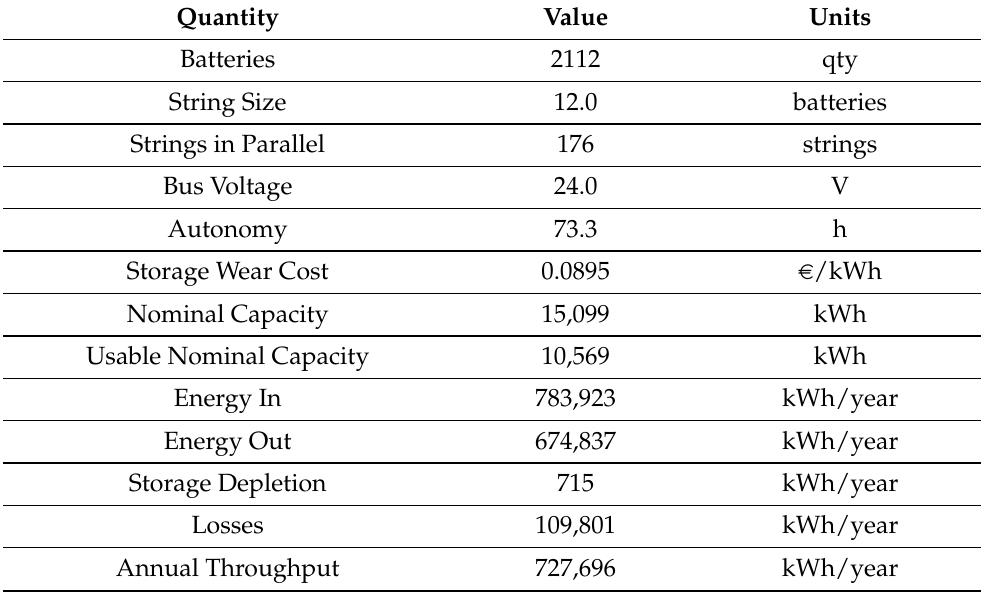
Table 28. Battery Scheme Simulation Results Case 2 Scenario